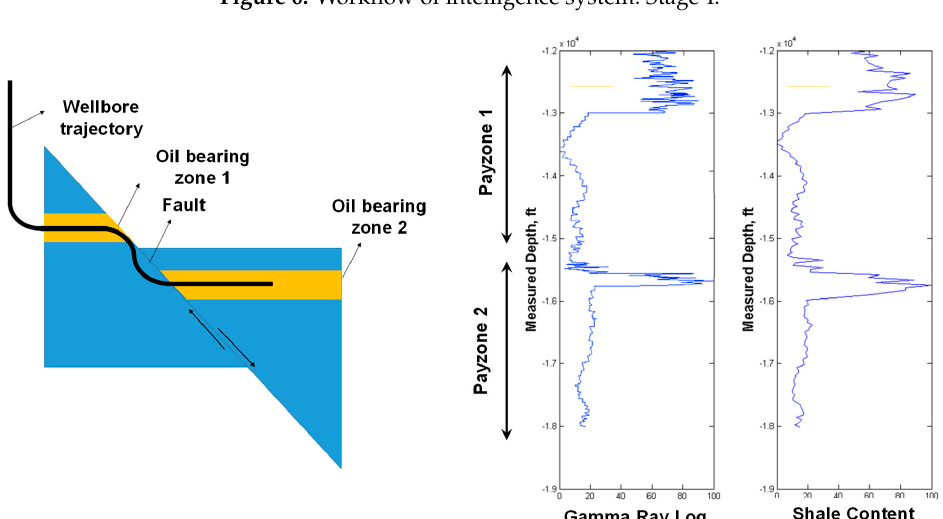
Figure 7. Synthetic logs for wells penetrating two horizontal pay zones.